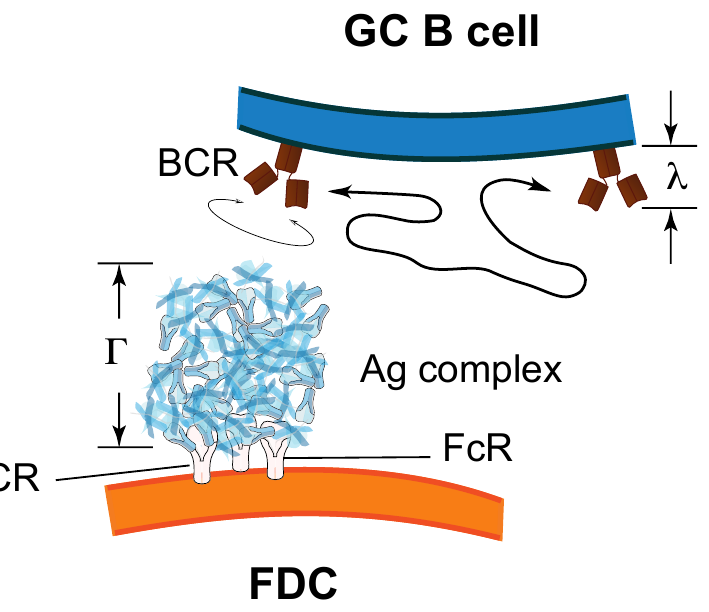
Figure 4. BCRs contribute to translational and rotational diffusion to a much larger extent than Ag complexes on FDCs (termed iccosomes). Iccosomes are tethered to the FDC membrane through several Fc and/or complement receptors. Typical diameter of iccosomes is Γ = 250–700 nm [42], while BCR diameter is λ = 10–15 nm [23]. FcR, Fc receptor; CR, complement